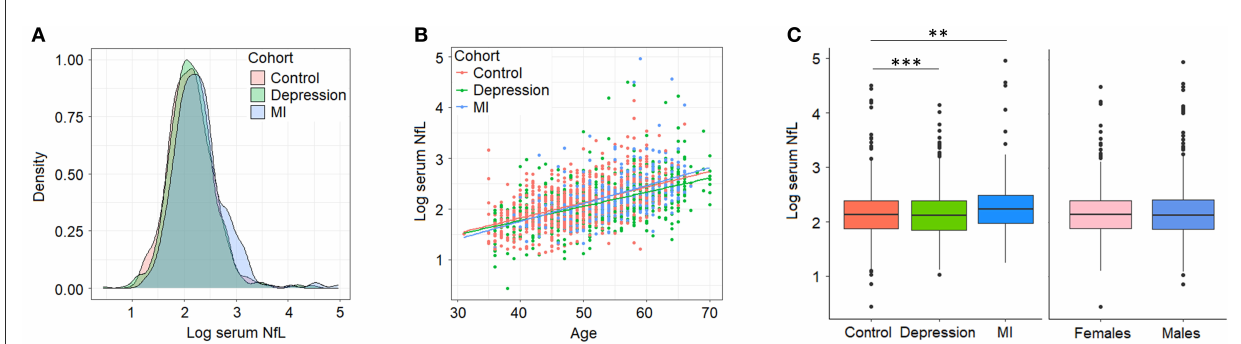
FIGURE1 Serum neurofilament light chain (NfL) levels (log2-transformed) in BiDirect. Cohorts showed similar distributions of sNfL concentrations (A) . There was a positive correlation of sNfL with age (B) . Mean differences associated with the diagnostic group (BiDirect cohort: depression, myocardial infarction-MI-, and population-based control individuals), but not with sex, were observed (C) . ** p < 0.001, *** p < 0.0001.